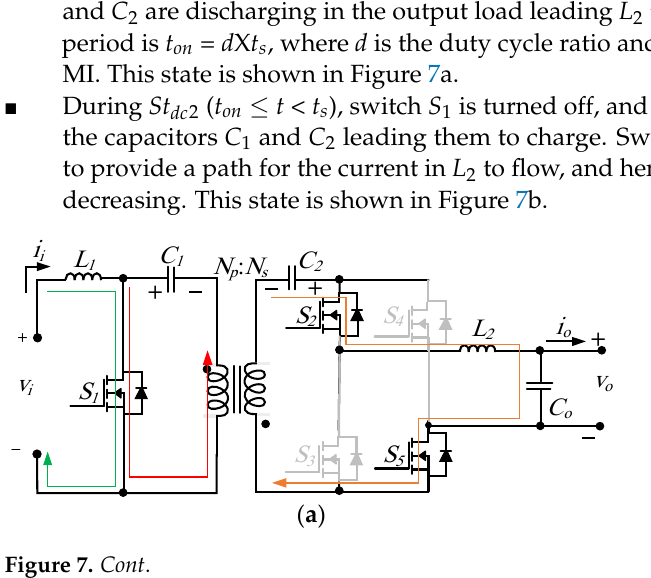
Figure 6. Cuk-based MI with isolation.